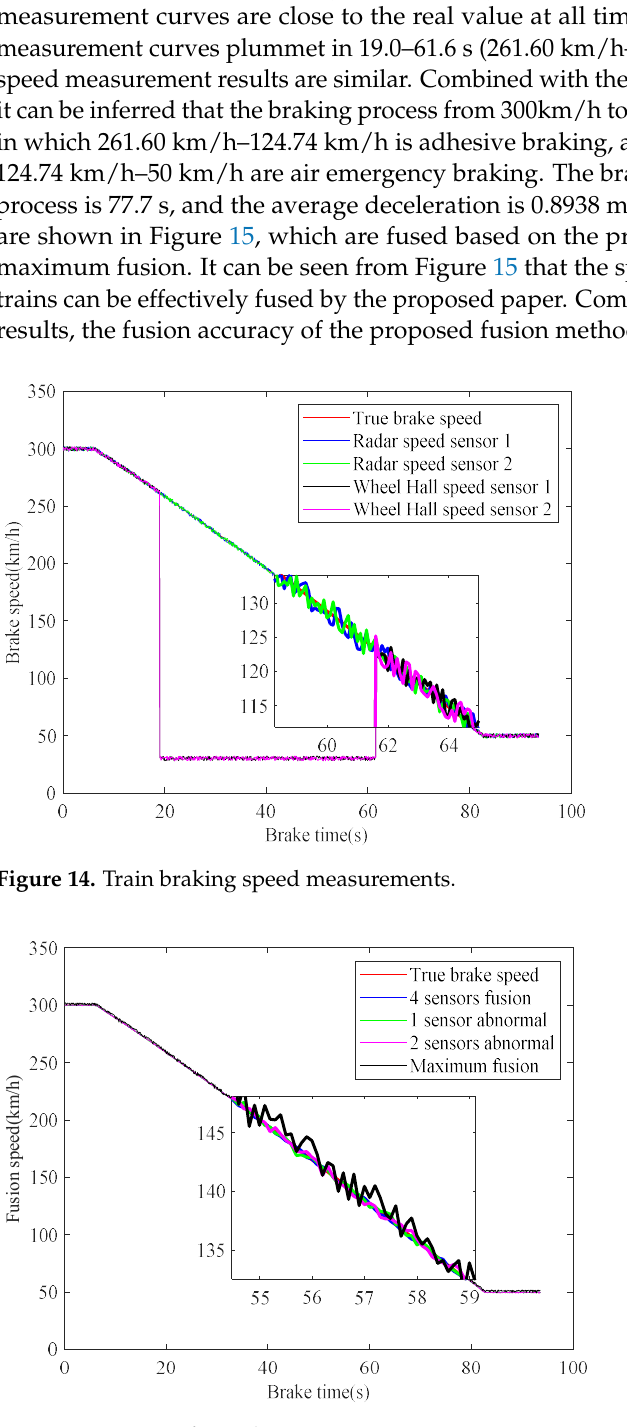
Figure 15. Fusion of speed sensors.